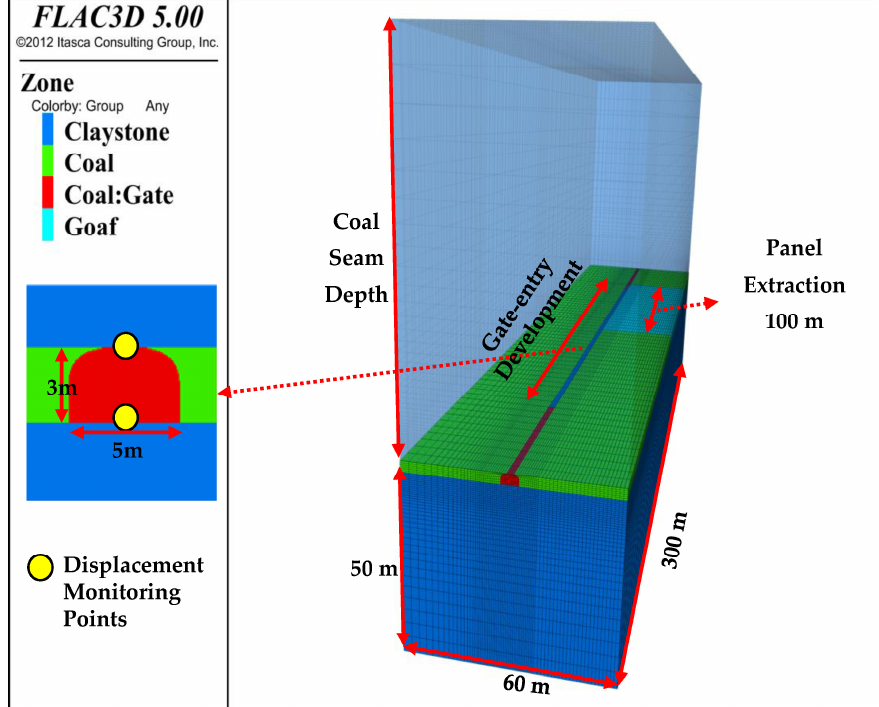
Energies 2020 , 13 , x FOR PEER REVIEW